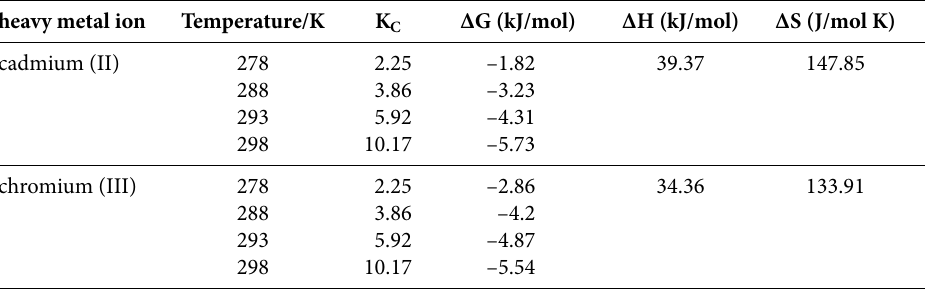
Table 3: Thermodynamic properties for cadmium (II) and chromium (III) adsorption heavy metal